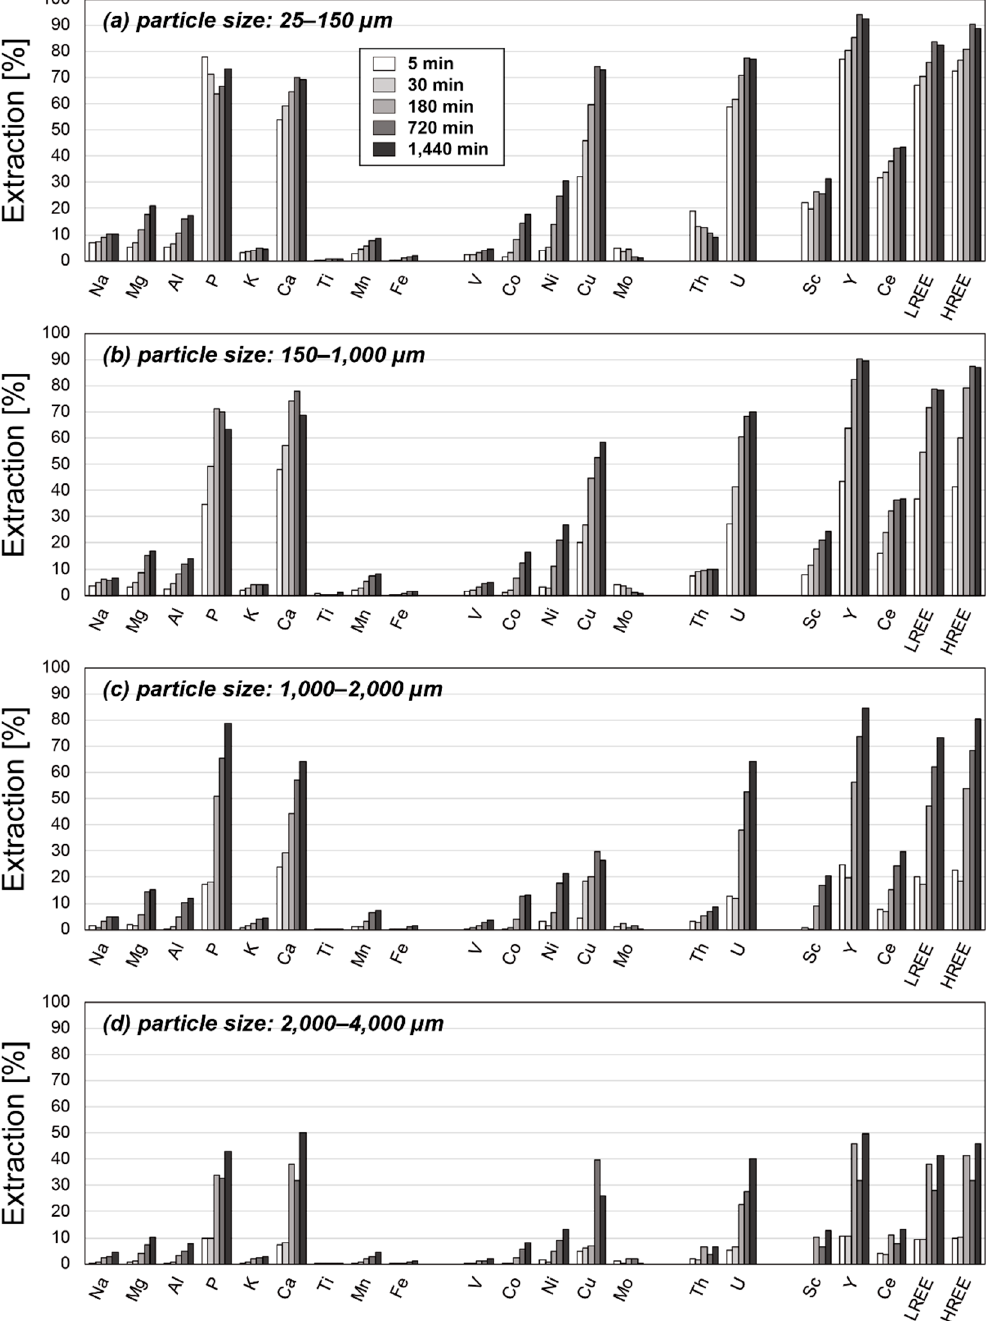
Figure 5. Extraction percentages of major elements, valuable metals, radioactive elements, and REE from the Aki umber as a function of time using hydrochloric acid as a leachate. Experiments with the